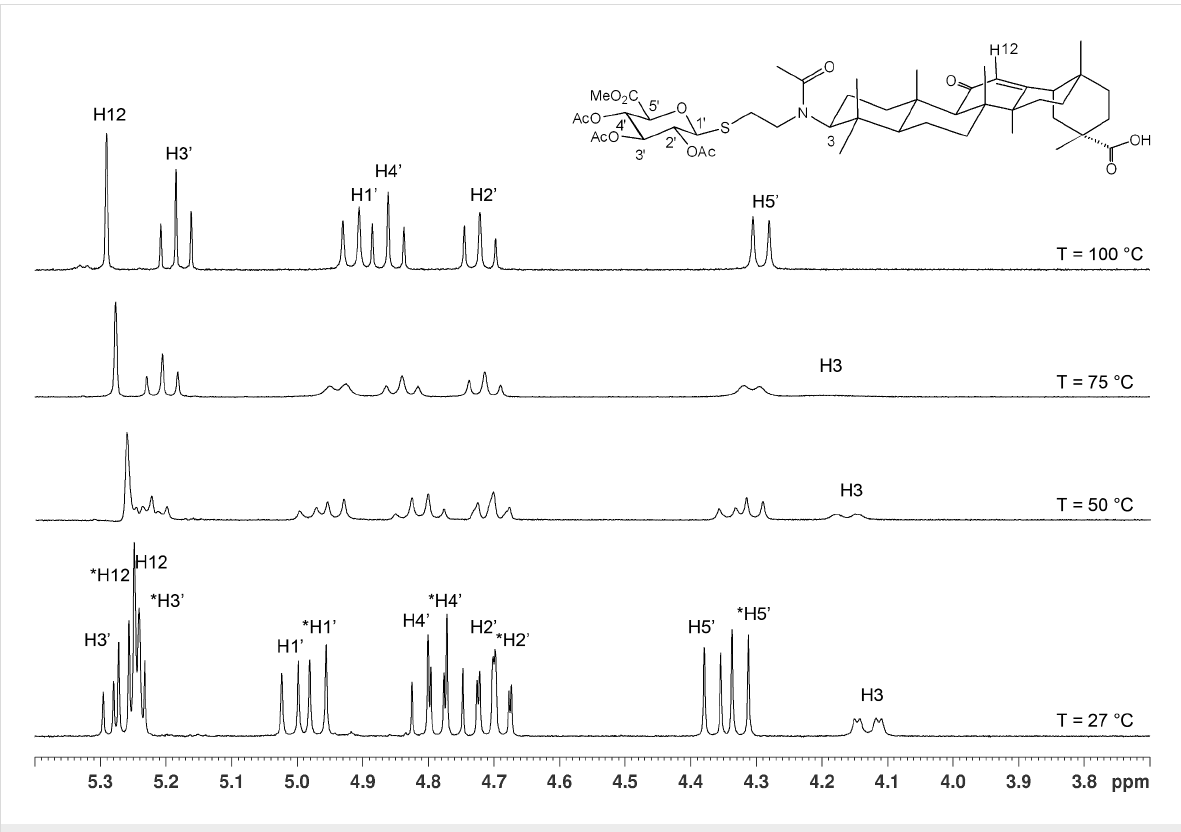
Figure 2: 400 MHz 1 H NMR expansion plots of the carbohydrate region of compound 11 , recorded at various temperatures.